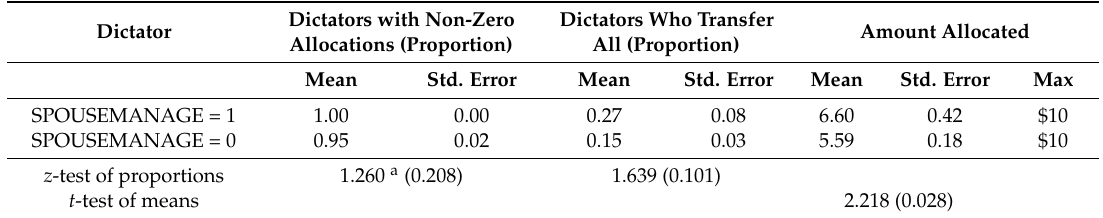
Table 5. Allocation of $10 based on SPOUSEMANAGE.